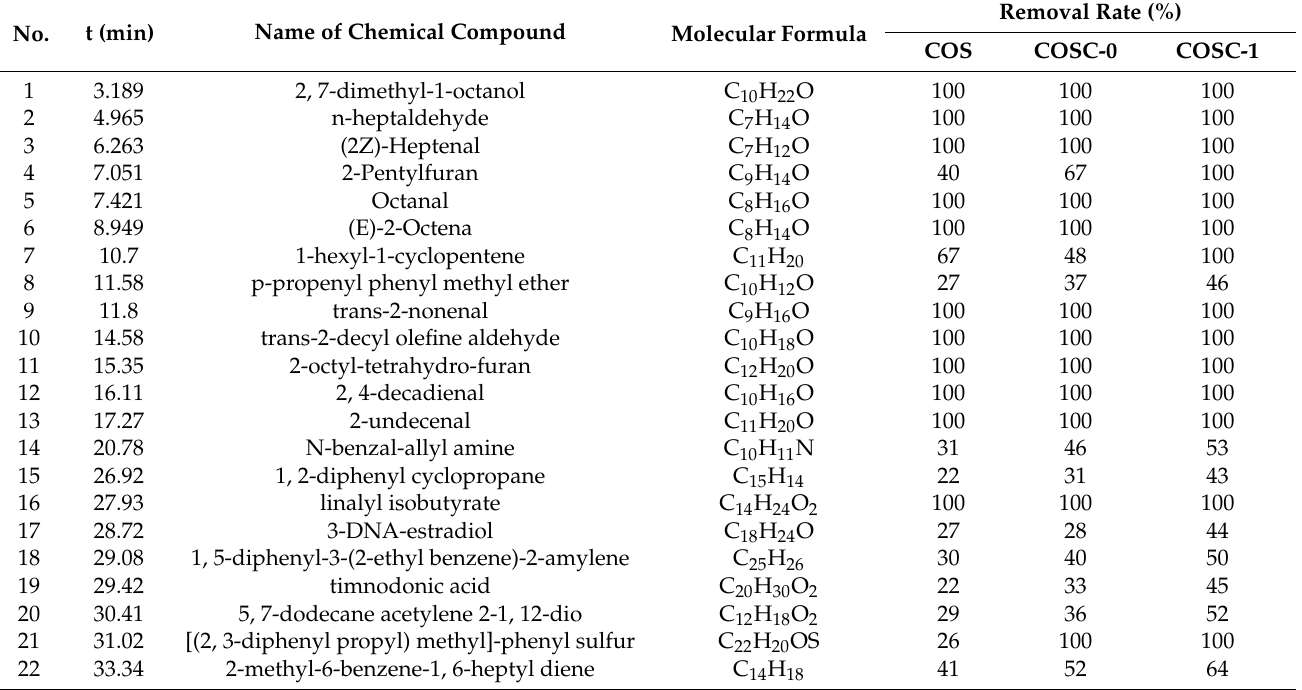
Table 1. Results of the cooking fume pollutants treated by different